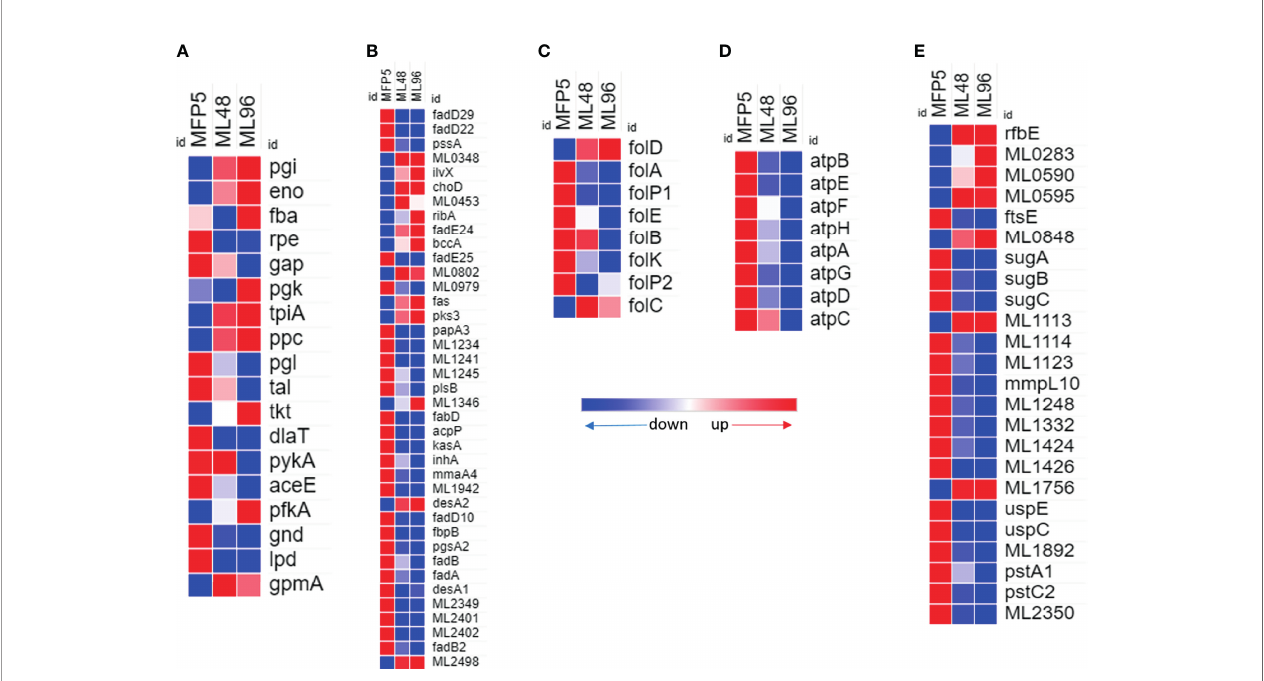
FIGURE 3 | Differential expression (average abundance) of M. leprae genes under in vivo (MFP5) and in vitro (ML48 & ML96) conditions. (A) glucose metabolism (https://www.genome.jp/pathway/mle00010), (B) lipid metabolism (fatty acid biosynthesis - https://www.genome.jp/pathway/mle00061; fatty acid degradation - https://www.genome.jp/pathway/mle00071), (C) Folate biosynthesis (https://www.genome.jp/pathway/mle00790), (D) ATP biosynthesis and (E) transporter